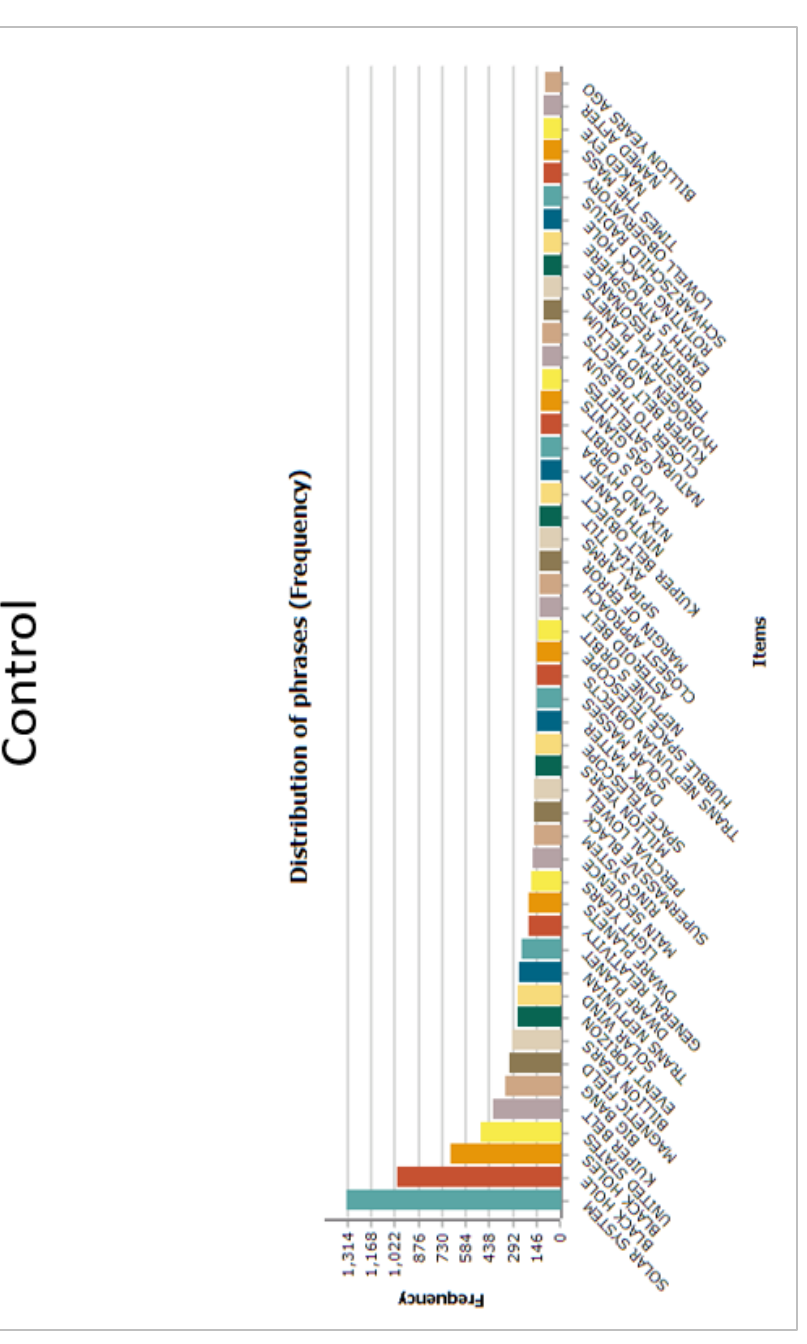
Fig. 8. Distribution of phrases for control